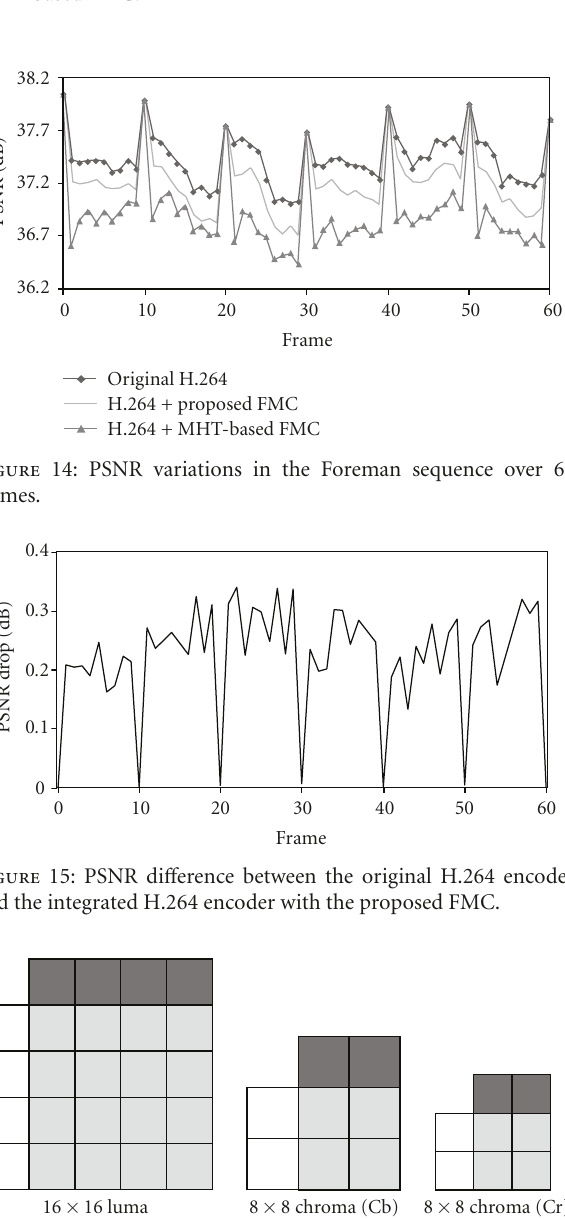
Figure 13: Subjective quality comparison for Mobile Calendar sequence: (a) original H.264, (b) H.264 + Proposed FMC, and (c) H.264 + MHT-based FMC.